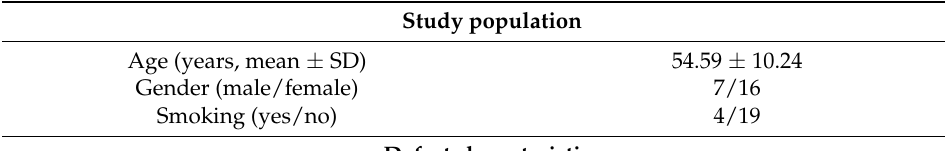
Table 1. Patient and defect characteristics (respectively, n = 23 and n =